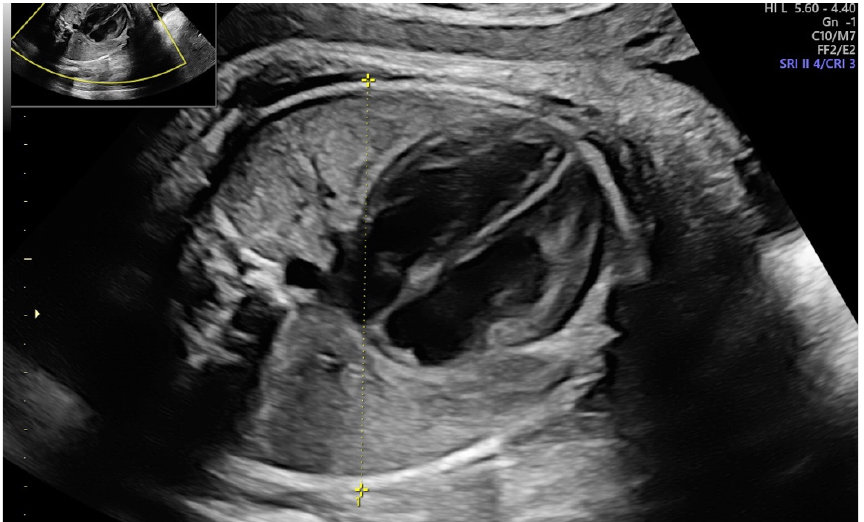
Figure 2. Transverse thoracic diameter (TTD) estimated by determining a transverse section of the fetal chest at the level of the heart (4-chamber view).